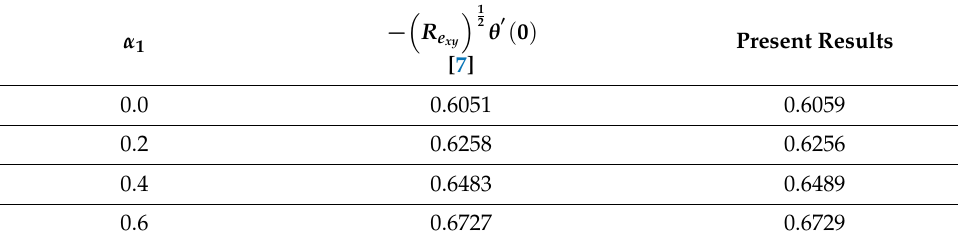
Table 3. Comparative investigation for heat transfer rate against α 1 .